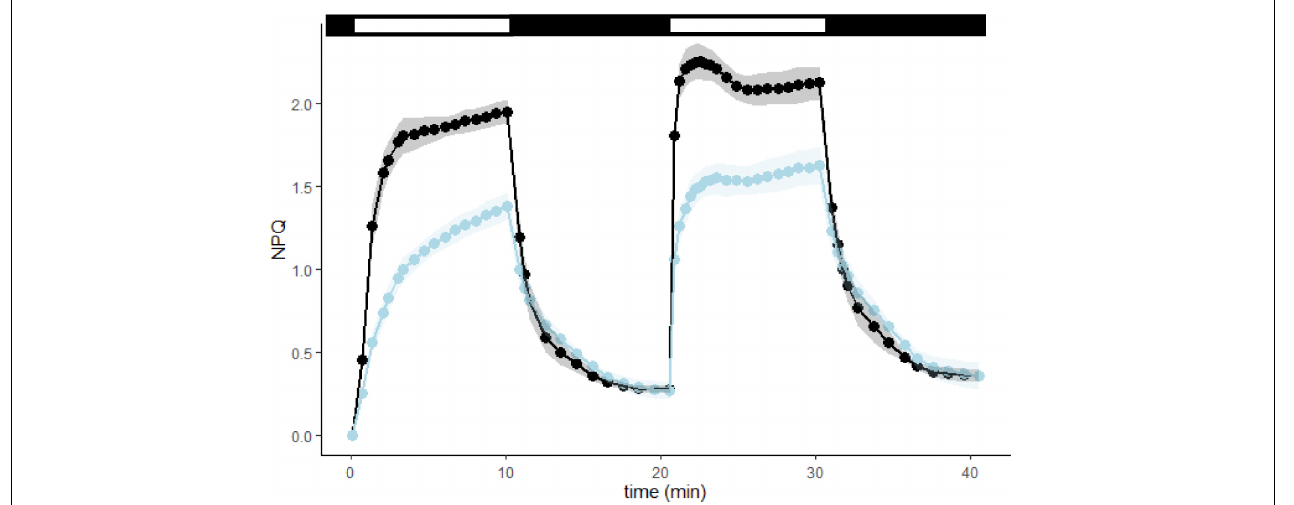
FIGURE 5 | L1ko is affected in the rapidly reversible component of NPQ (qE). NPQ kinetics with two periods of light induction, both at 1,000 µ mol photons m – 2 s – 1 , measured in WT and L1ko adult plants. The top bar shows the light exposition periods (white bars) and the dark relaxation (black bars). The points and the lines correspond to the average NPQ value recorded for each time from five biological replicates. The lines and areas show a continuous estimate of the average and the standard deviation for WT (the black line and the gray area) and L1ko (the blue line and the light blue area). The corresponding fluorescence traces are shown in Supplementary Figure 9